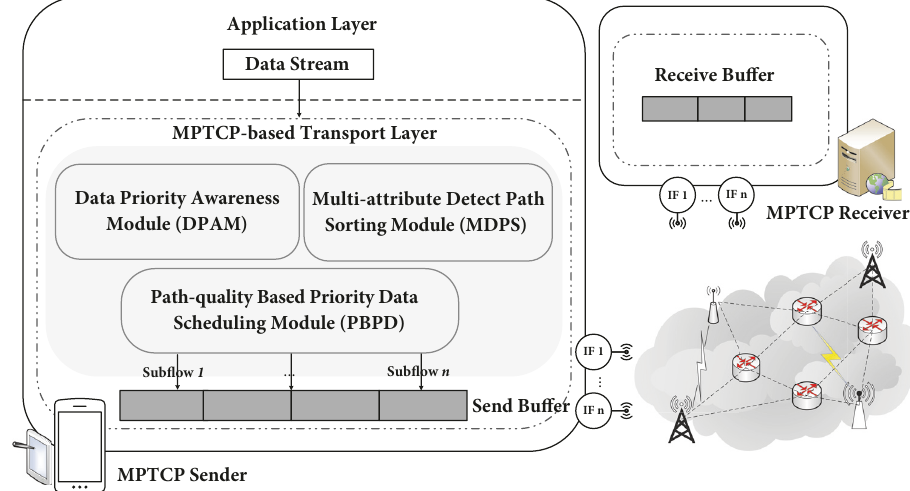
Figure 2: Architecture of the priority-oriented MPTCP data transmission